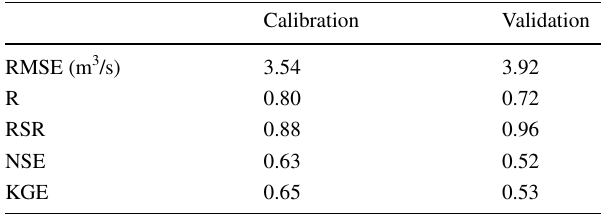
Table 1 Performance criteria for IHACRES model